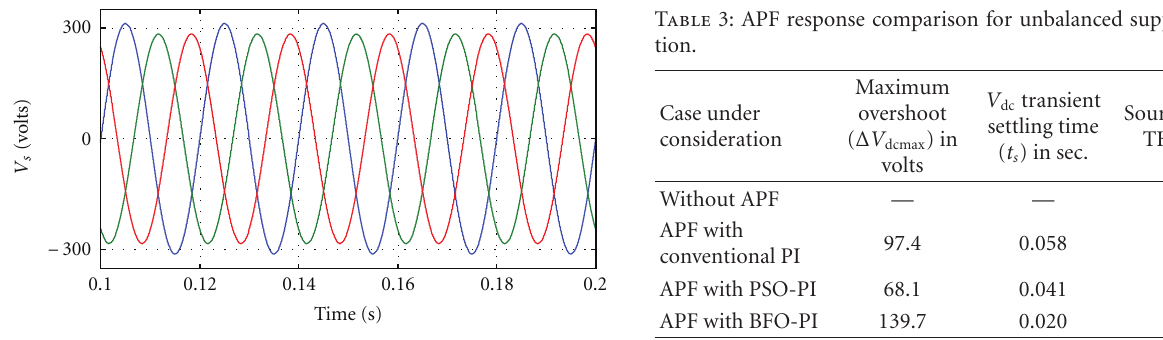
Figure 10: Unbalanced supply voltage waveform.